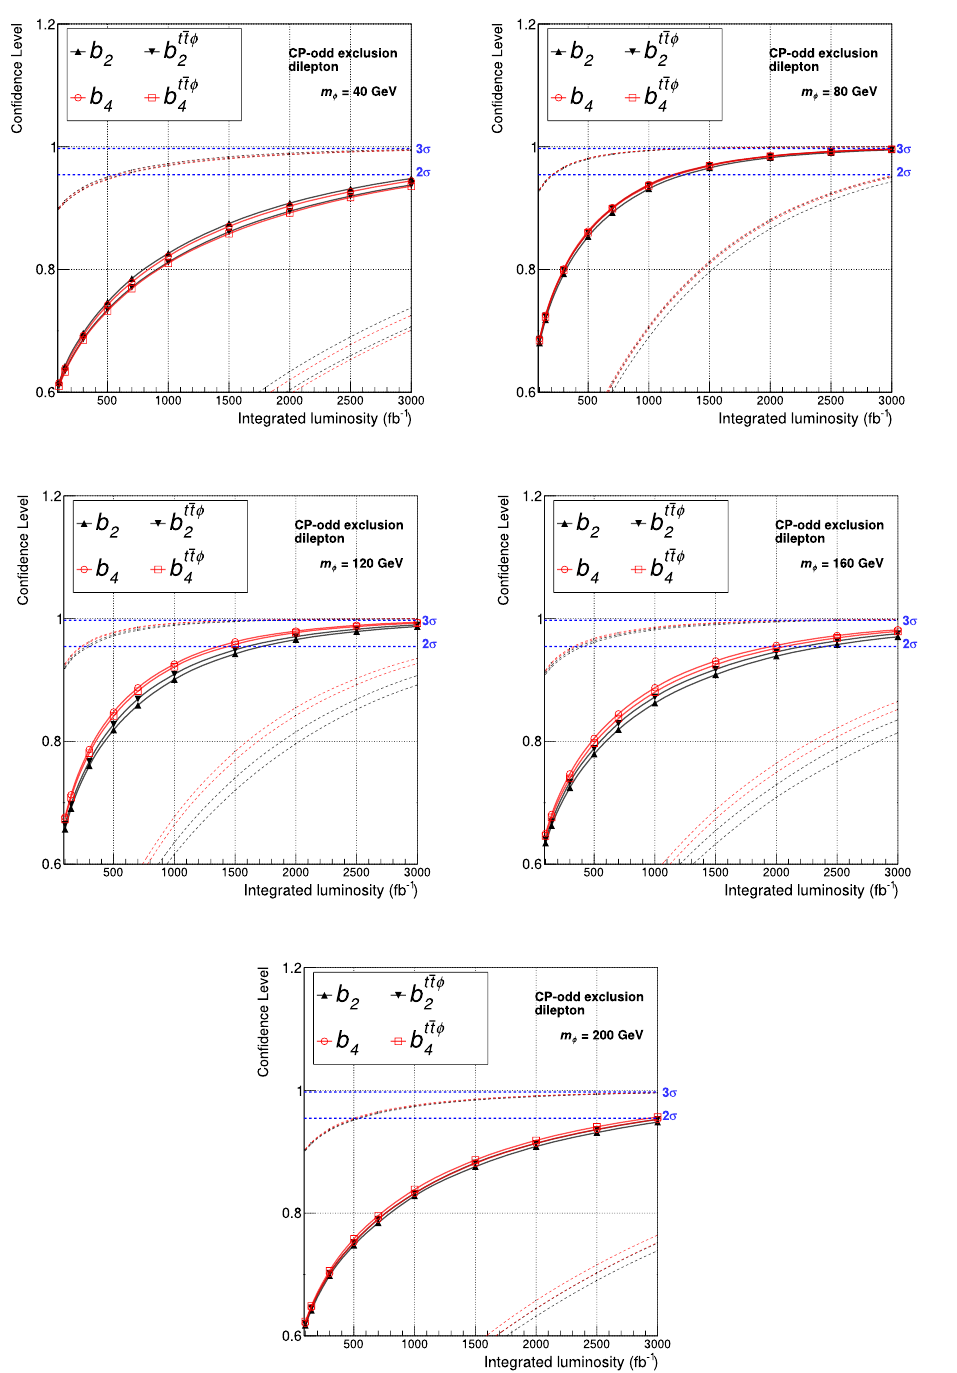
Figure 18. Expected CLs for CP-odd exclusion assuming the SM (scenario 2), as a function of the integrated luminosity.